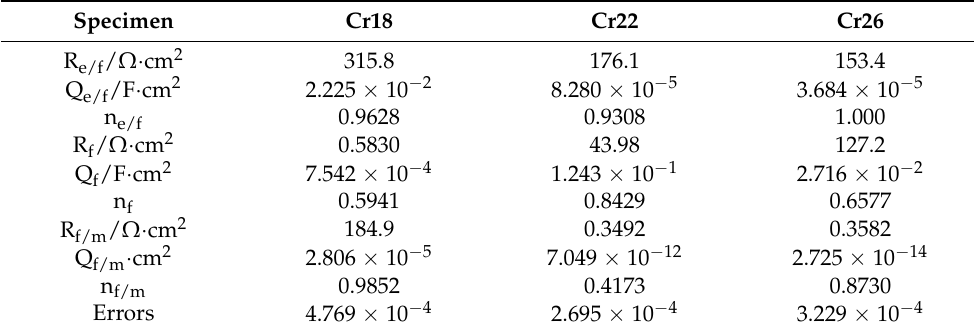
Table 2. EIS fitted results for Cr18, Cr22, and Cr26 in 50 wt.% H 2 SO 4 solution at 60 ◦